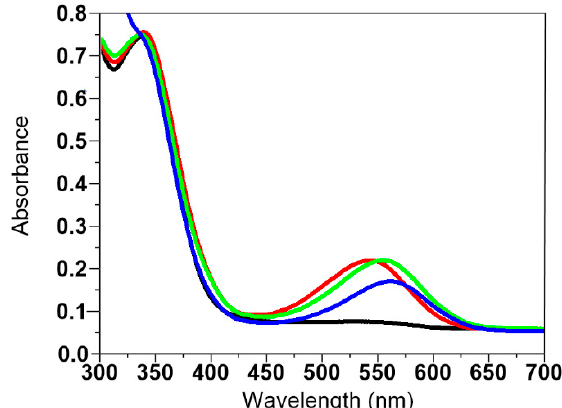
Figure 5. Absorption spectra of solutions of SP-PMOVE (0.1 mM) without UV irradiation (black line) and SP-PMOVE (0.1 mM) in iPrOH (blue line), EtOH (green line) and MeOH (red line) at 25 °C upon UV irradiation for 2 min.